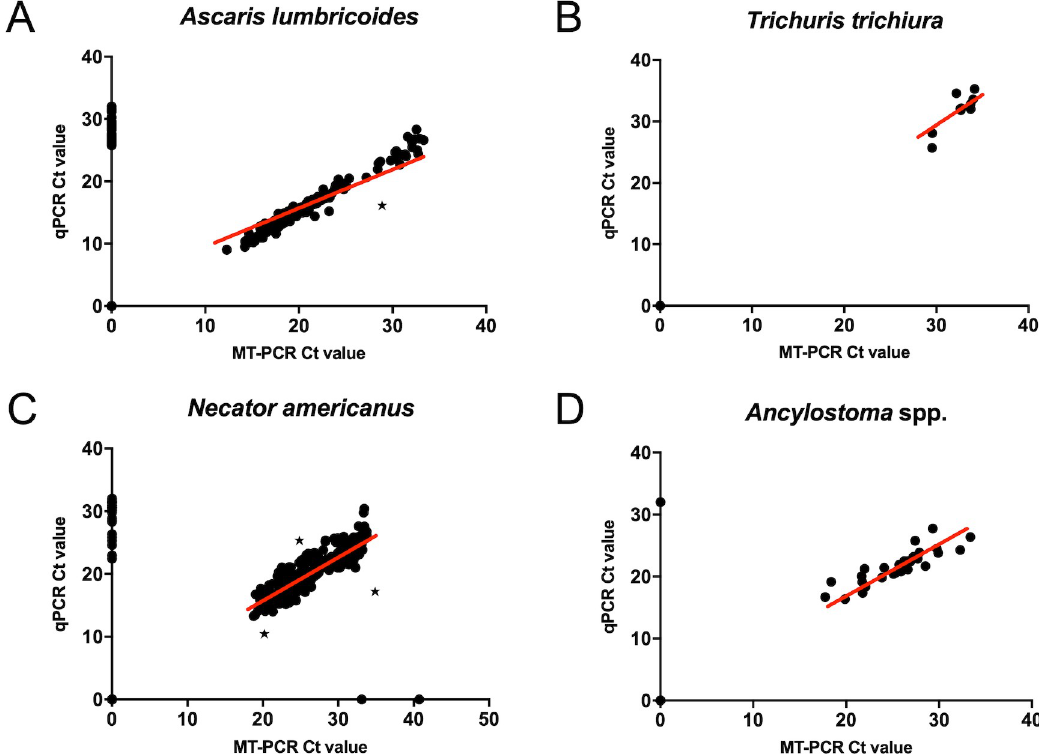
Fig 2. Cycle threshold (Ct) value scatterplot for all investigated STH species showing agreement of multiplexed qPCR and MT-PCR for all samples tested infection positive by either none, one or both molecular diagnostic methods. Ascaris lumbricoides (A) Trichuris trichiura (B) Necator americanus (C) Ancylostoma spp. combined values for A . duodenale and A . ceylanicum (D). Highlighted samples were removed for analysis of coefficient of determination which determines the closeness of data to a fitted linear regression line using only samples deemed infection positive by both molecular diagnostic methods ( �